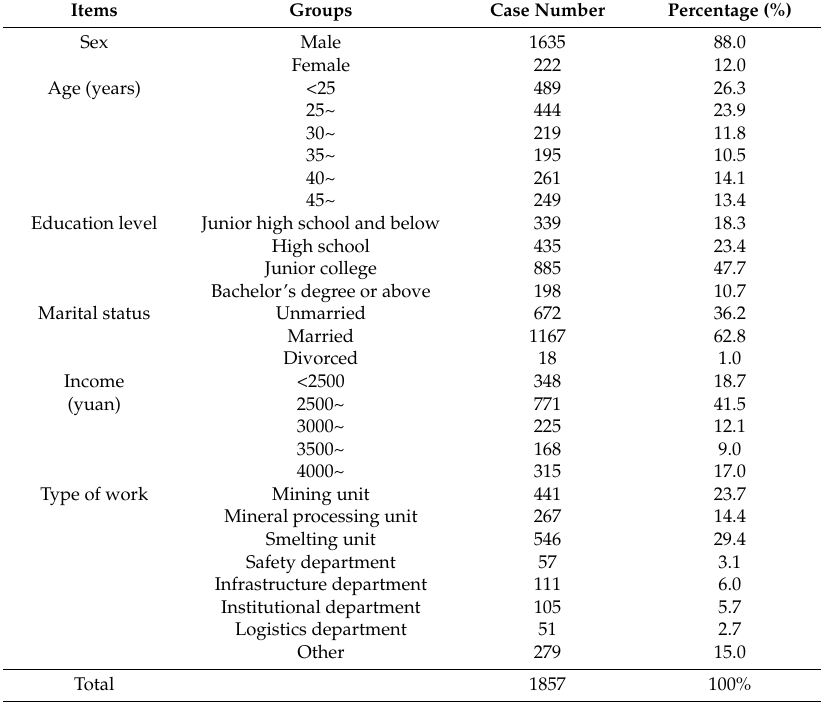
Table 1. Characteristics of the copper-nickel worker sample